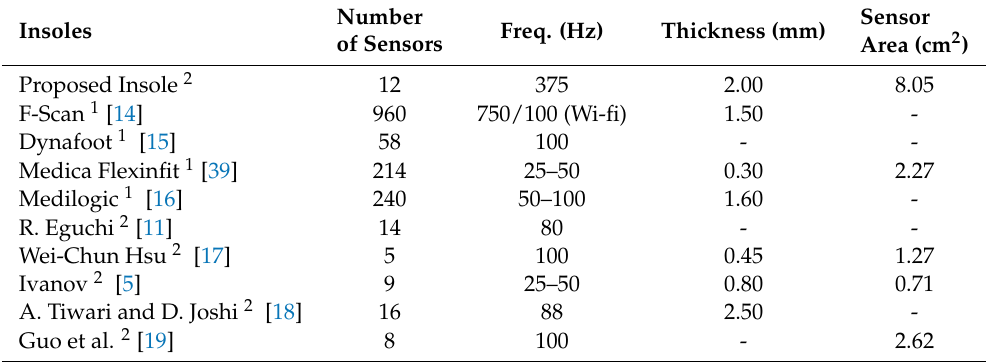
Table 1. Comparison among the most popular resistive sensorized